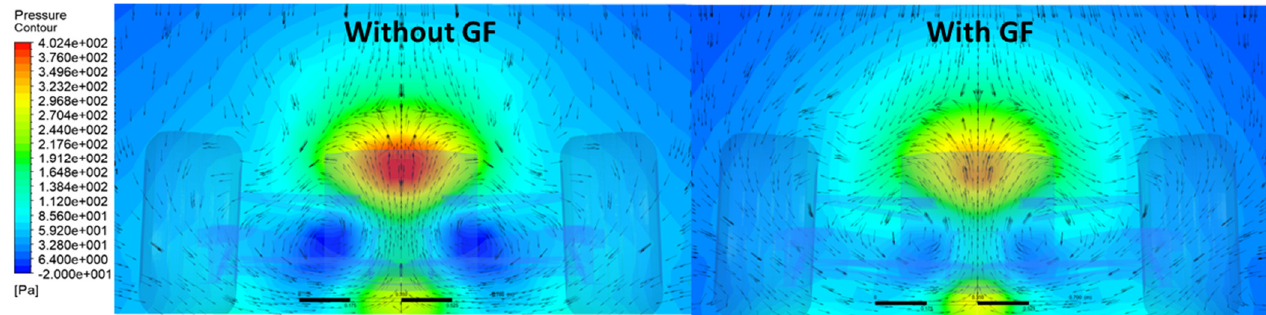
Figure 17. Comparison of pressure contours with velocity vectors on a downstream plane. Case with ( left ) and without ( right ) GF.